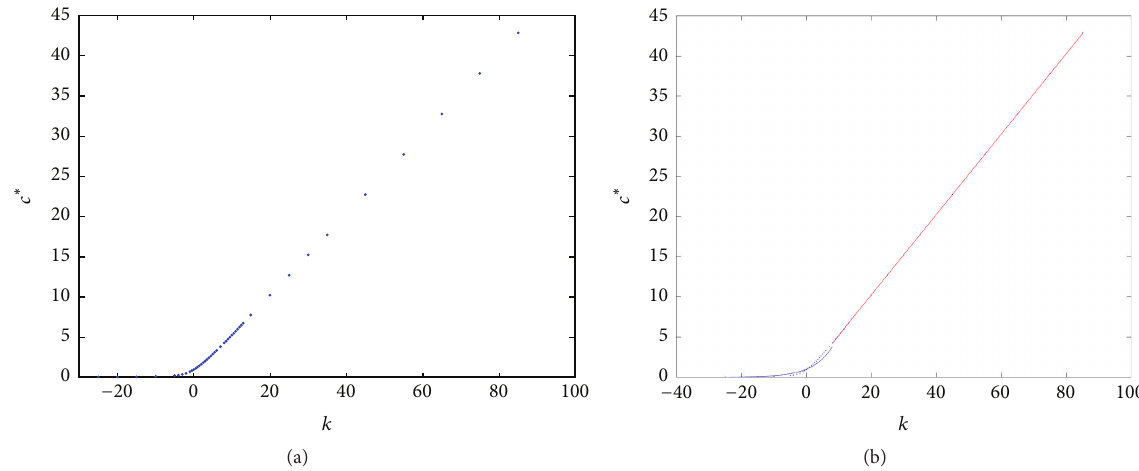
Figure 10: “Numerical experimental data” for 𝑐 ∗ for different values of 𝑘 with ℎ 󸀠 (𝑢) = 𝑘𝑢 . The data as they were obtained (a); the fitting (b).